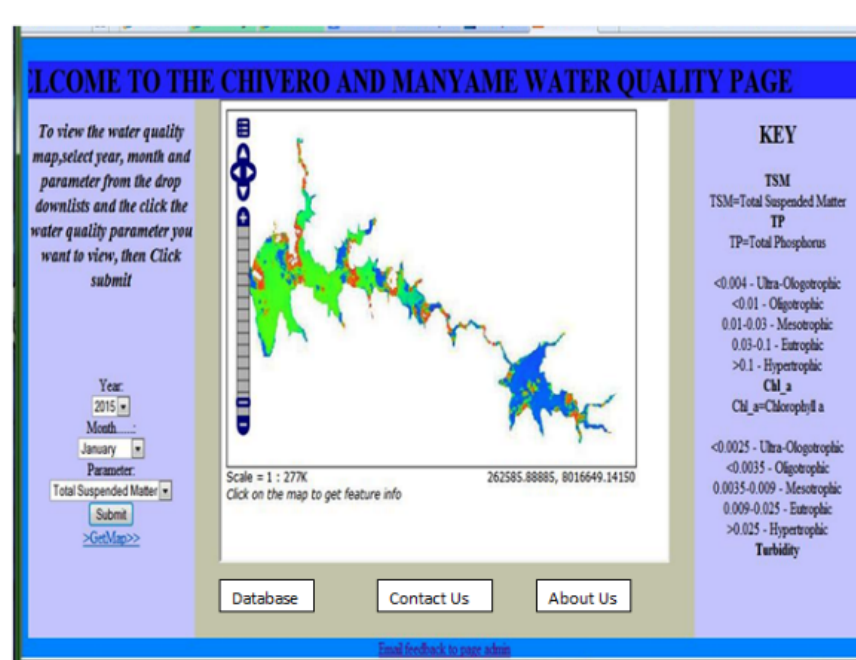
Figure 7. The web accessible interface to water quality